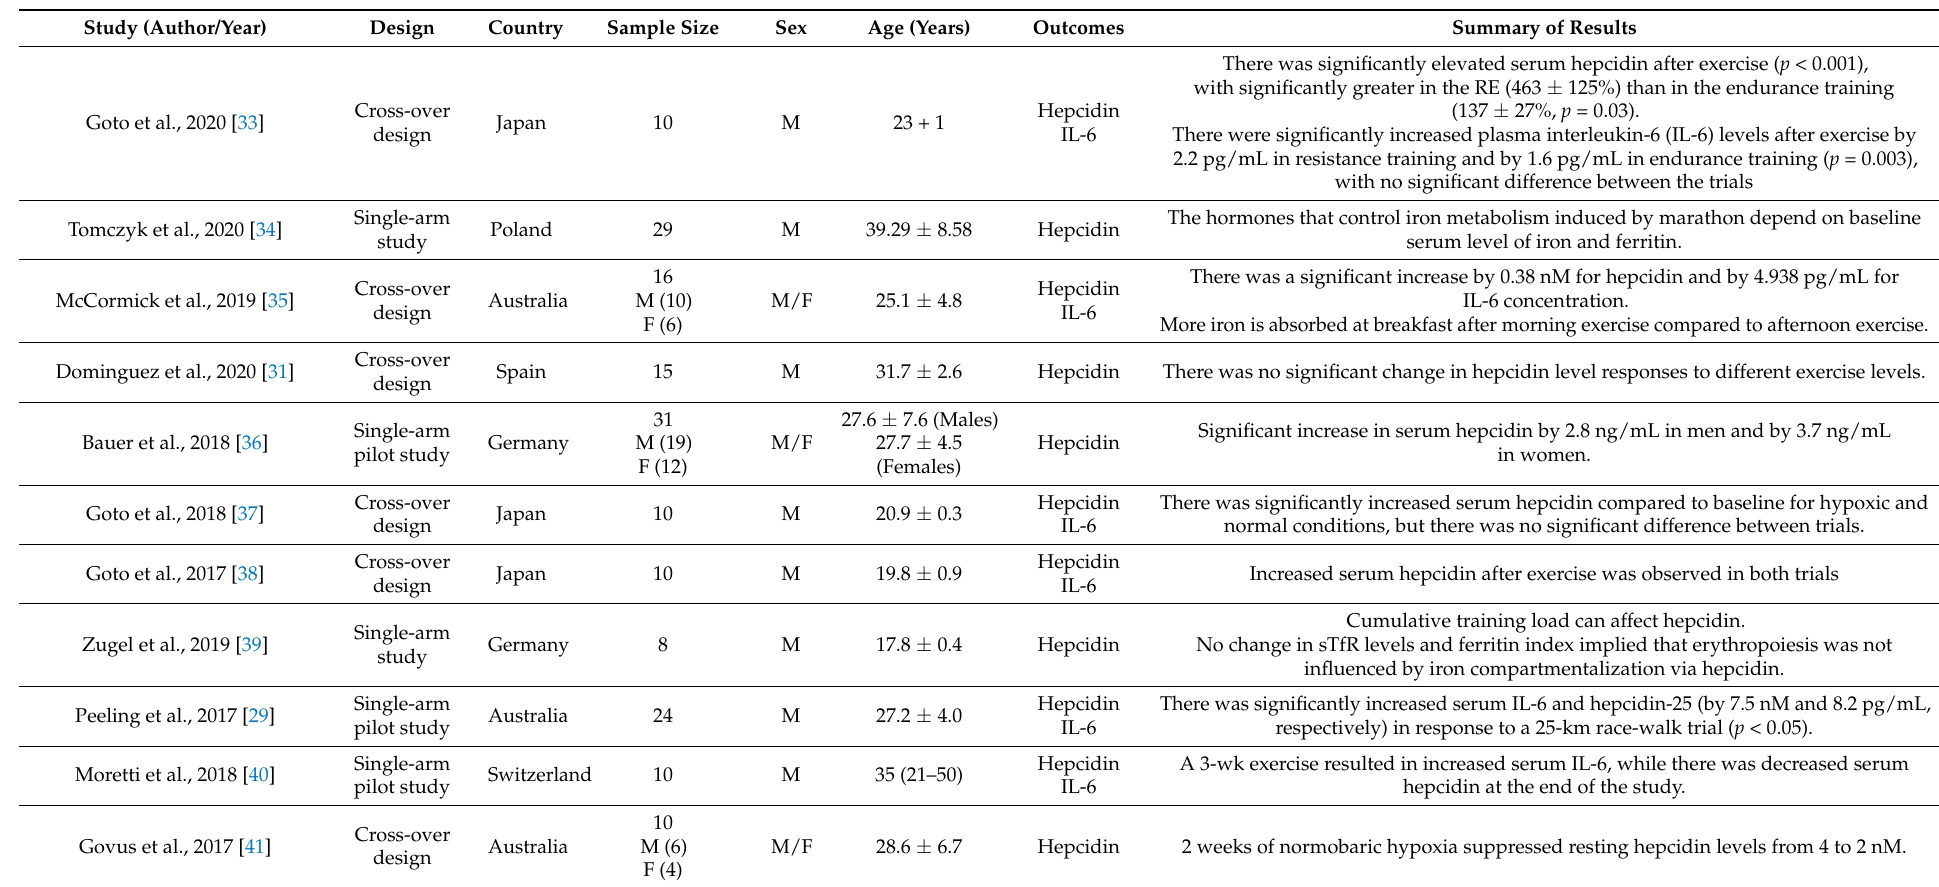
Table 2. Characteristics of the